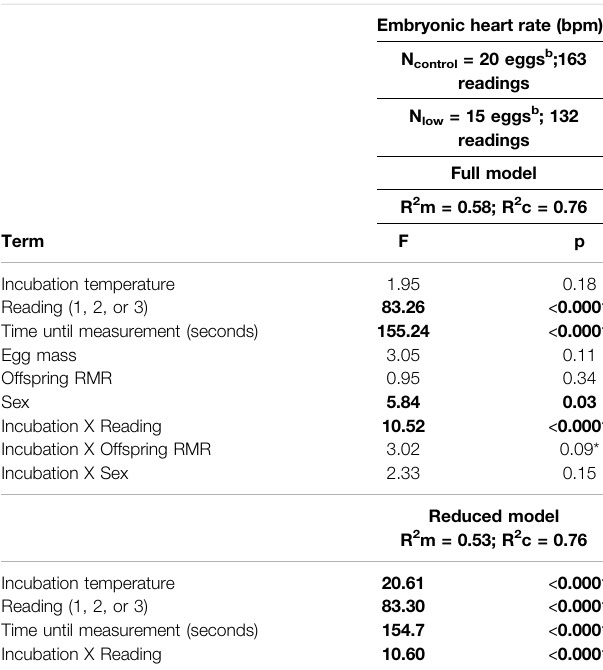
TABLE 5 | Full and reduced models investigating the relationship between embryonic heart rate and Day 30 metabolism.